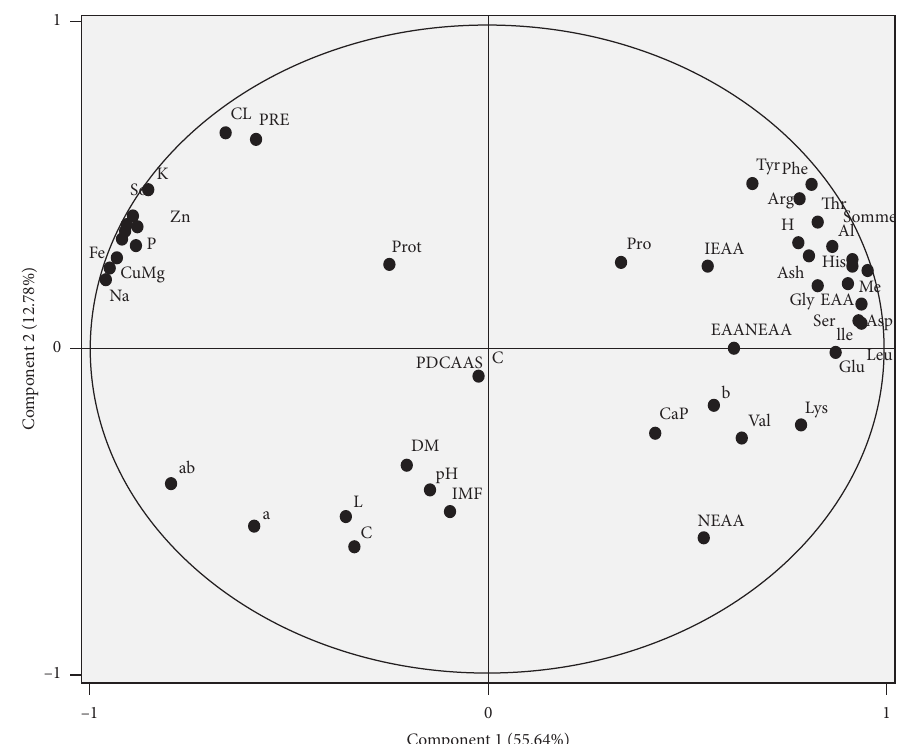
Figure 1: Projection of meat constituents and quality characteristics parameters in the plane defined by two principal components.